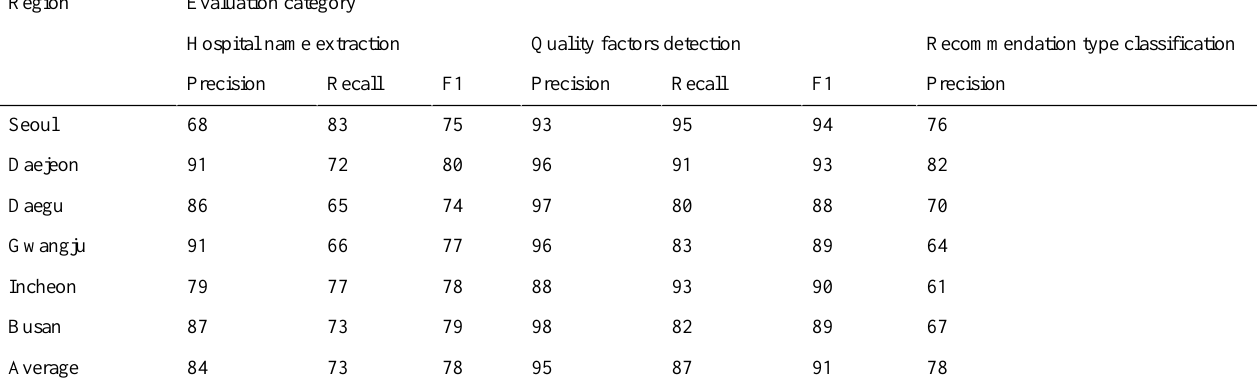
Table 3. Evaluation results (reported as